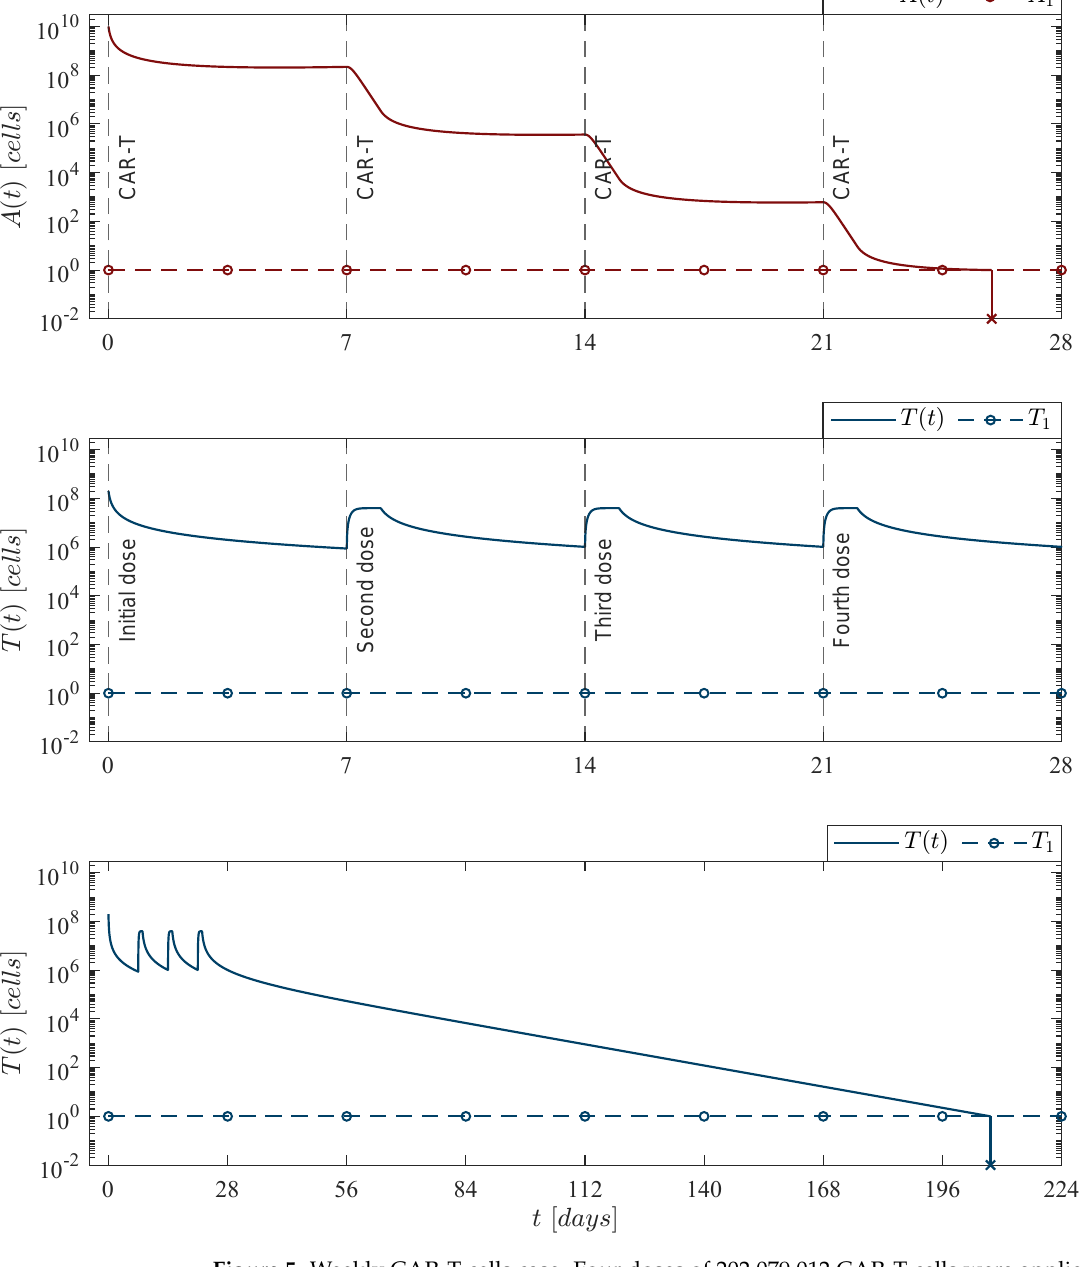
Figure 5. Weekly CAR-T cells case. Four doses of 202,079,012 CAR-T cells were applied at days 0, 7, 14, and 21, for a total of 808,316,048 CAR-T cells infused into the system to achieve leukemia cancer cells eradication [ A ( t ) < 1 ] between days 25 and 26 [ t = 25.96 ] . The lower panel illustrates that CAR-T cells are completely depleted [ T ( t ) < 1 ] by day 208 [ t = 207.32 ] . For this case, parameter values are set as follows: ρ A = 0.1680, ρ T = 2.9409 × 10 − 13 , µ T = 1/14, and α T = 1.2560 × 10 − 7 by Equation